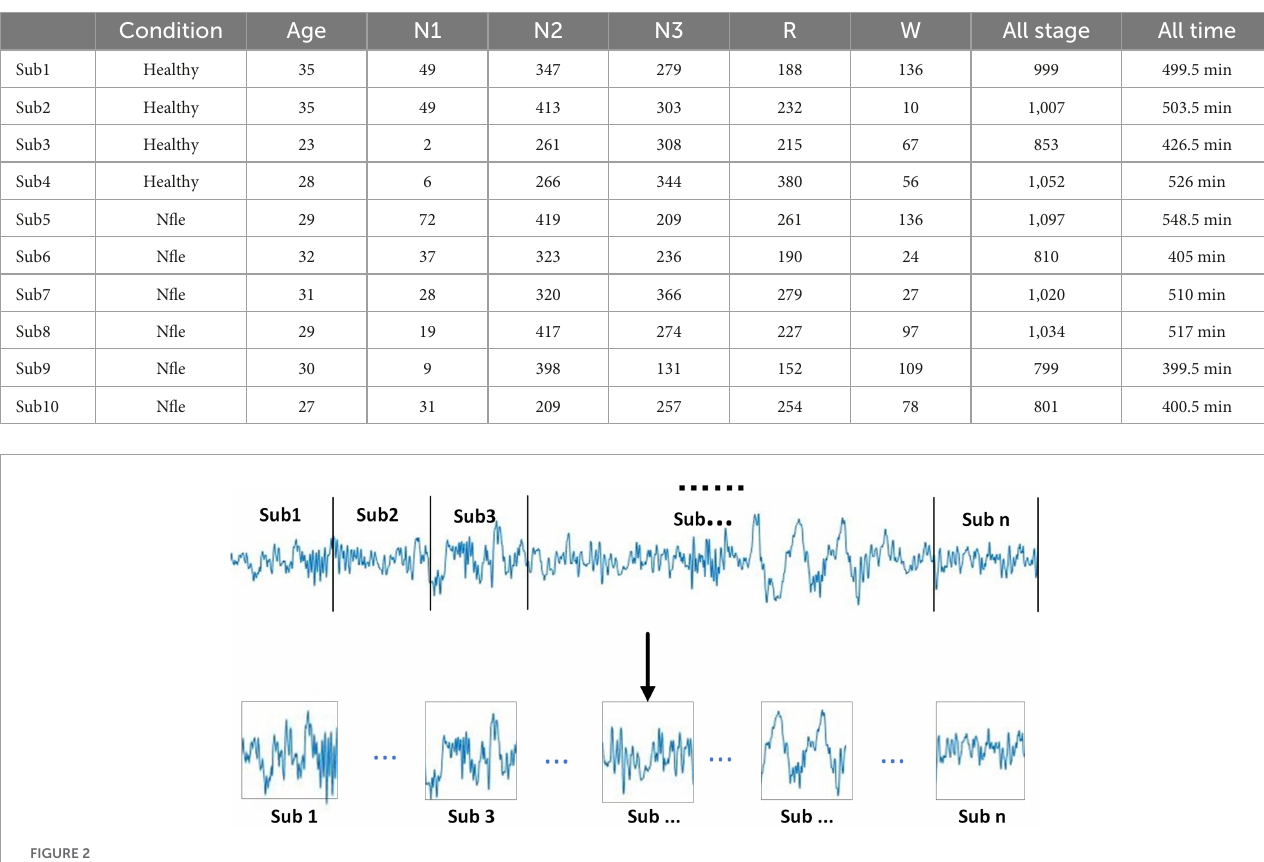
TABLE 1 Basic information about each subject and period numbers of each stage.